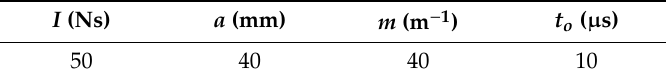
Table 2. Pressure distribution parameters.